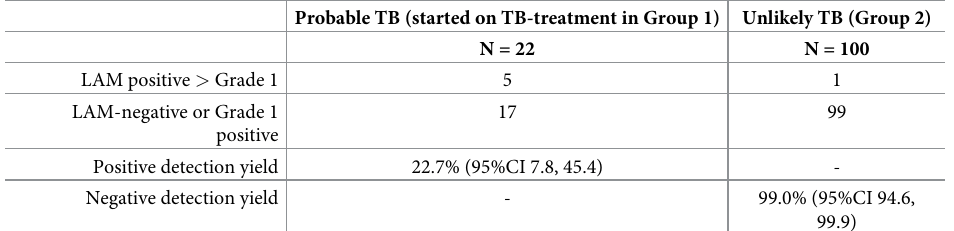
Table 4. TB LAM test results by TB symptoms and/or started on